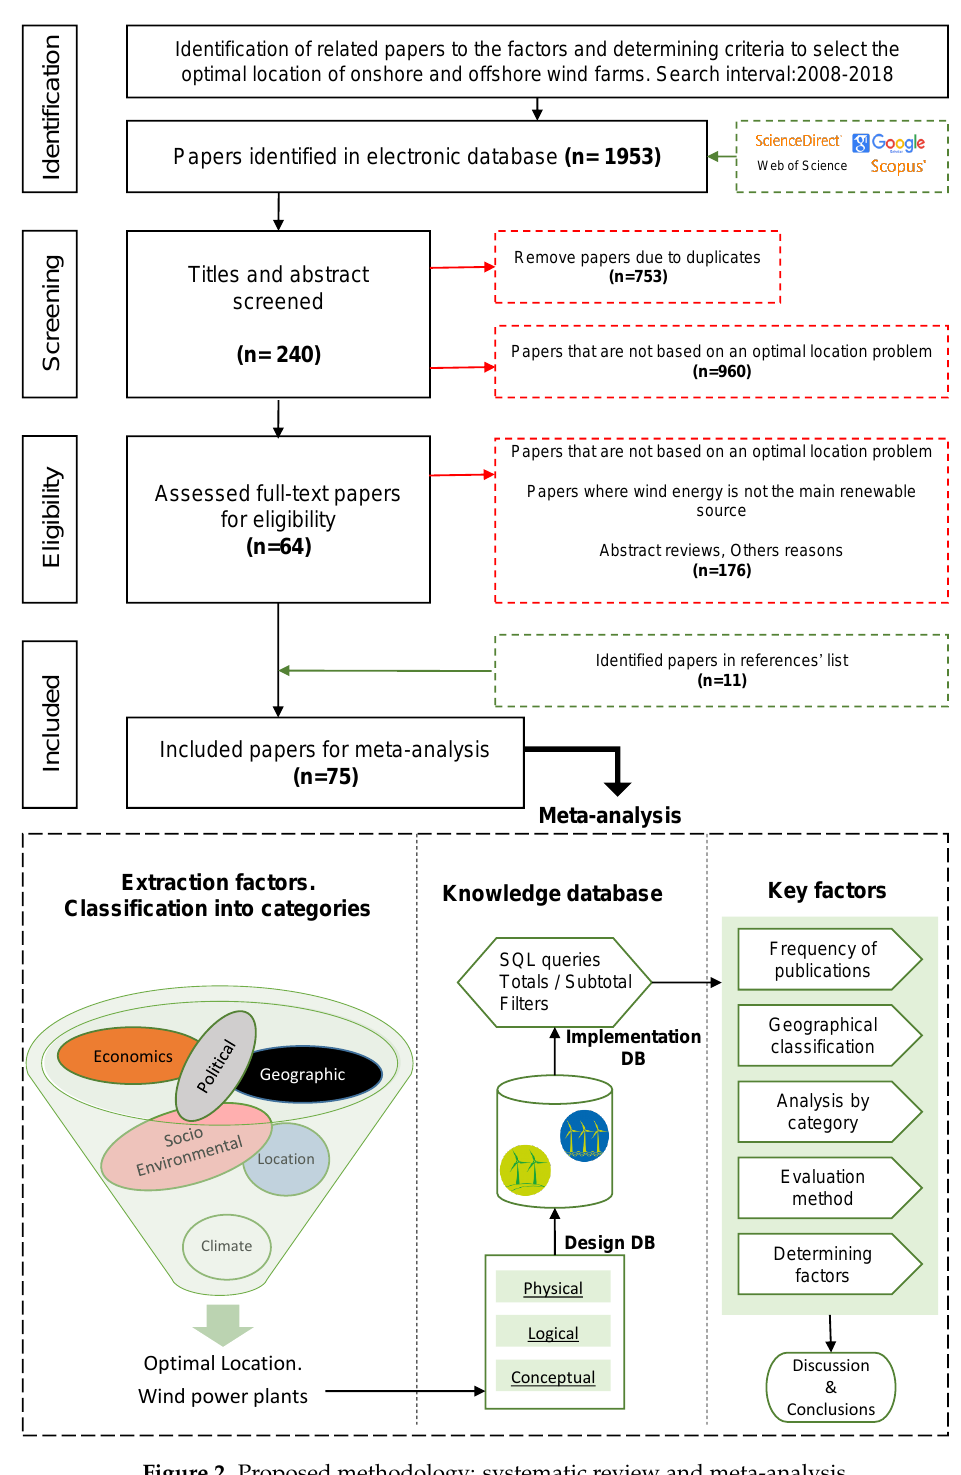
Figure 2. Proposed methodology: systematic review and